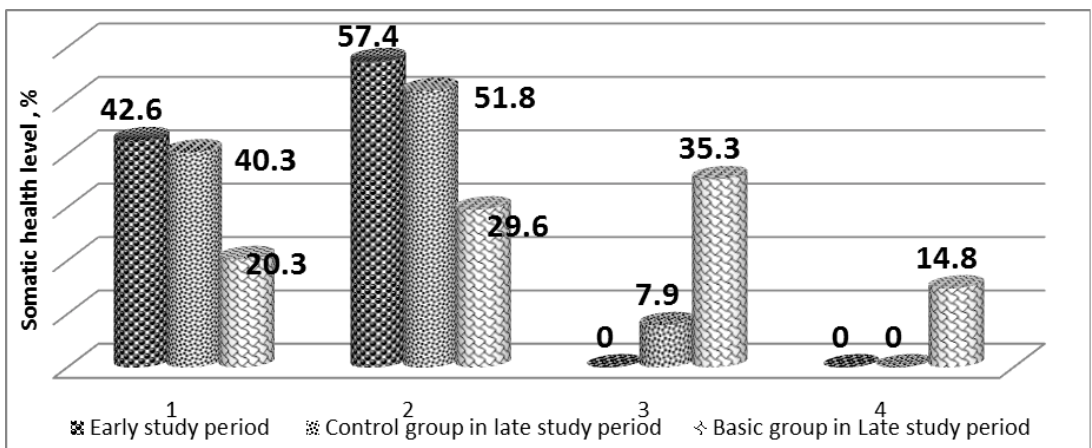
Figure 1. Dynamics of students somatic health level before and after the recreational swimming classes, % ( n = 54, n1 = n2 = 27). Note: 1 “poor” level, 2—“poorer than average”; 3—“average”; 4—“better than average”.